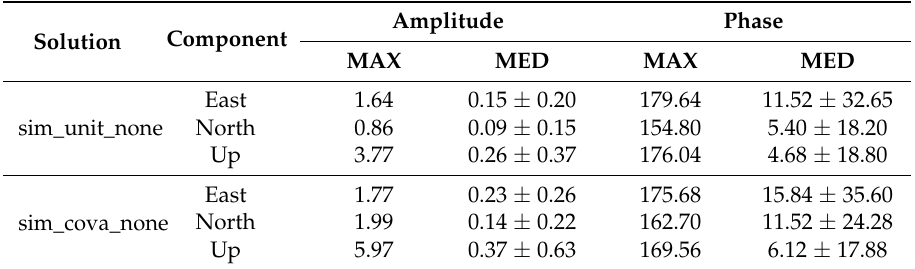
Table 2. Maximum and median values with the standard deviation (SD) of the annual amplitude and phase absolute difference between the raw simulated and solution sim_unit_none and sim_cova_none. Unit: mm and degree for amplitude and phase,